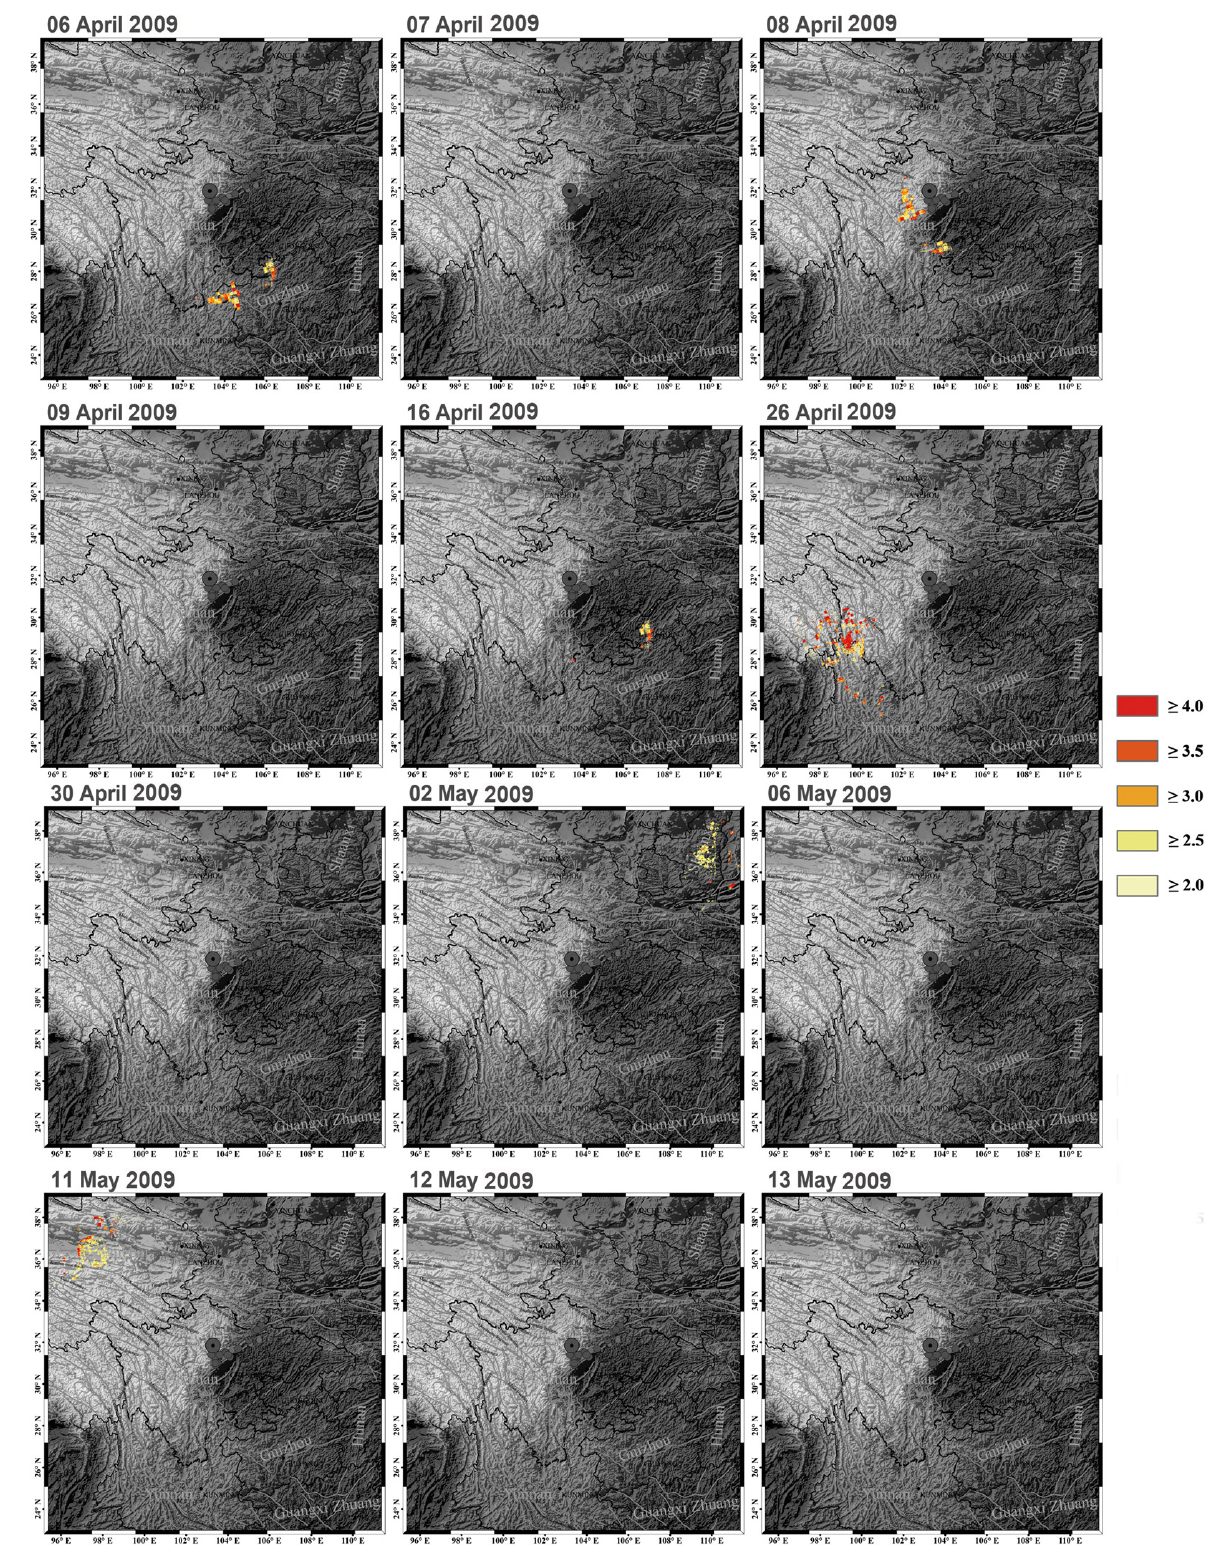
Figure 7. Results of the RETIRA index computation on the investigated area before and after the Wenchuan earthquake using AATSR BT data (Nadir view) from April 6, 2009, to May 13,